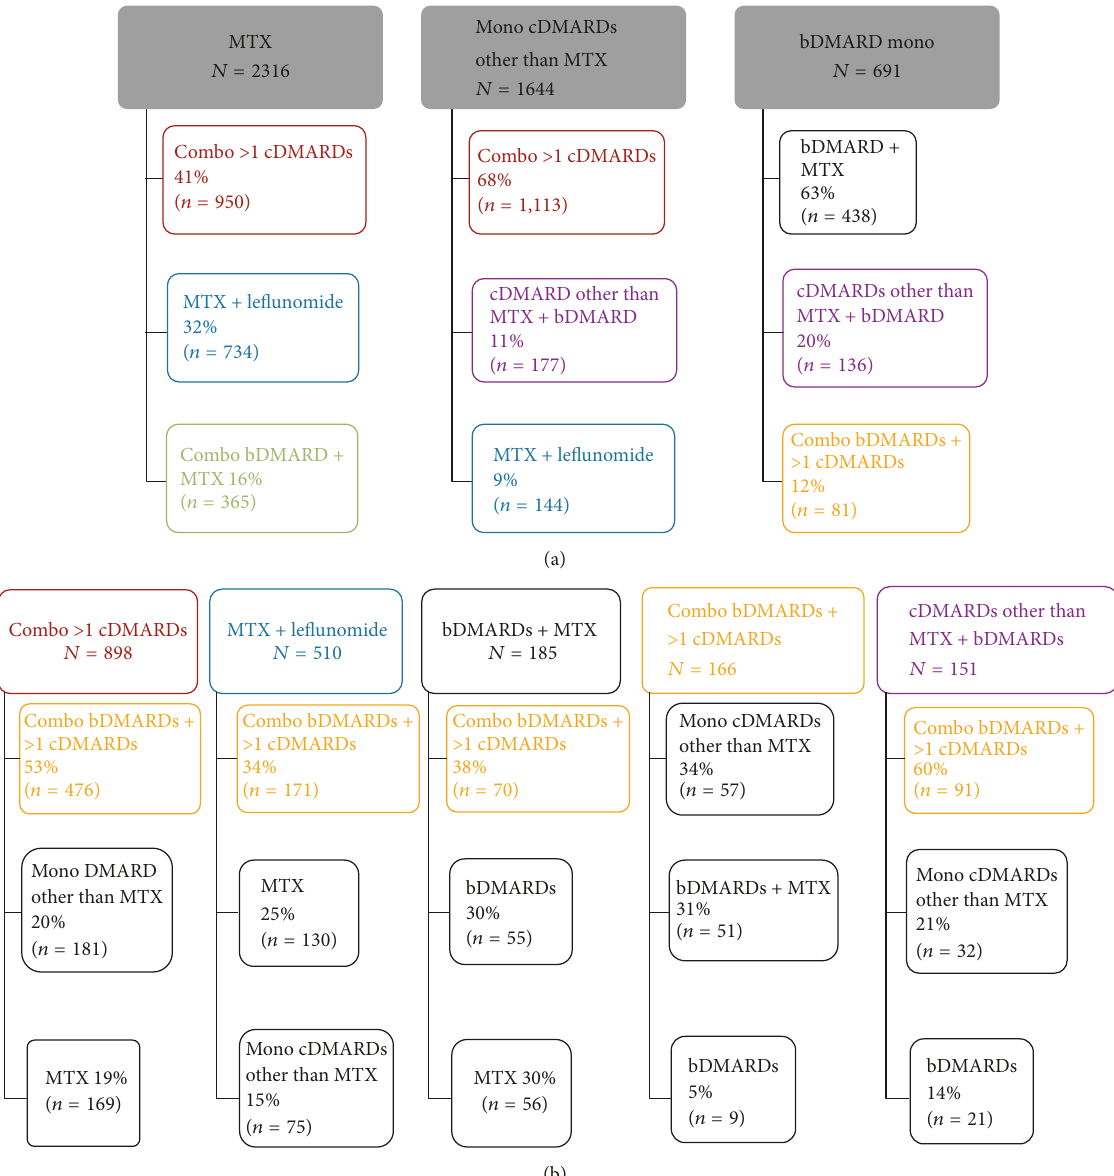
Figure 2: Most common treatment changes in RA medications at first and second change. (a) Treatment algorithm observed when DMARDs were first changed. (b) Treatment algorithm observed when DMARDs were changed a second time. Boxed groups at the top of each figure represent the patient’s medication group prior to the medication change. The lines lead to boxes beneath that represent the distribution of medication groups after the medication change. Combo = combination; mono = monotherapy; MTX = methotrexate. Percentages may not add up to 100% as only the most common changes are